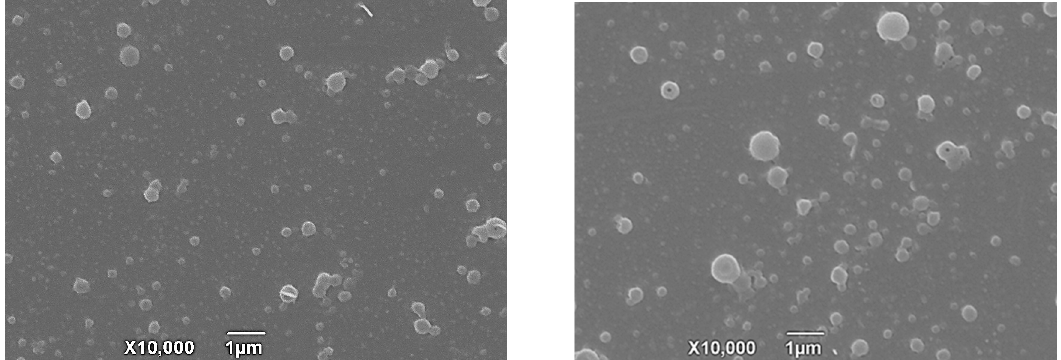
Figure 2. The scanning electron microscopy photographs of TIL-SLNs (left) and nanogel (right).